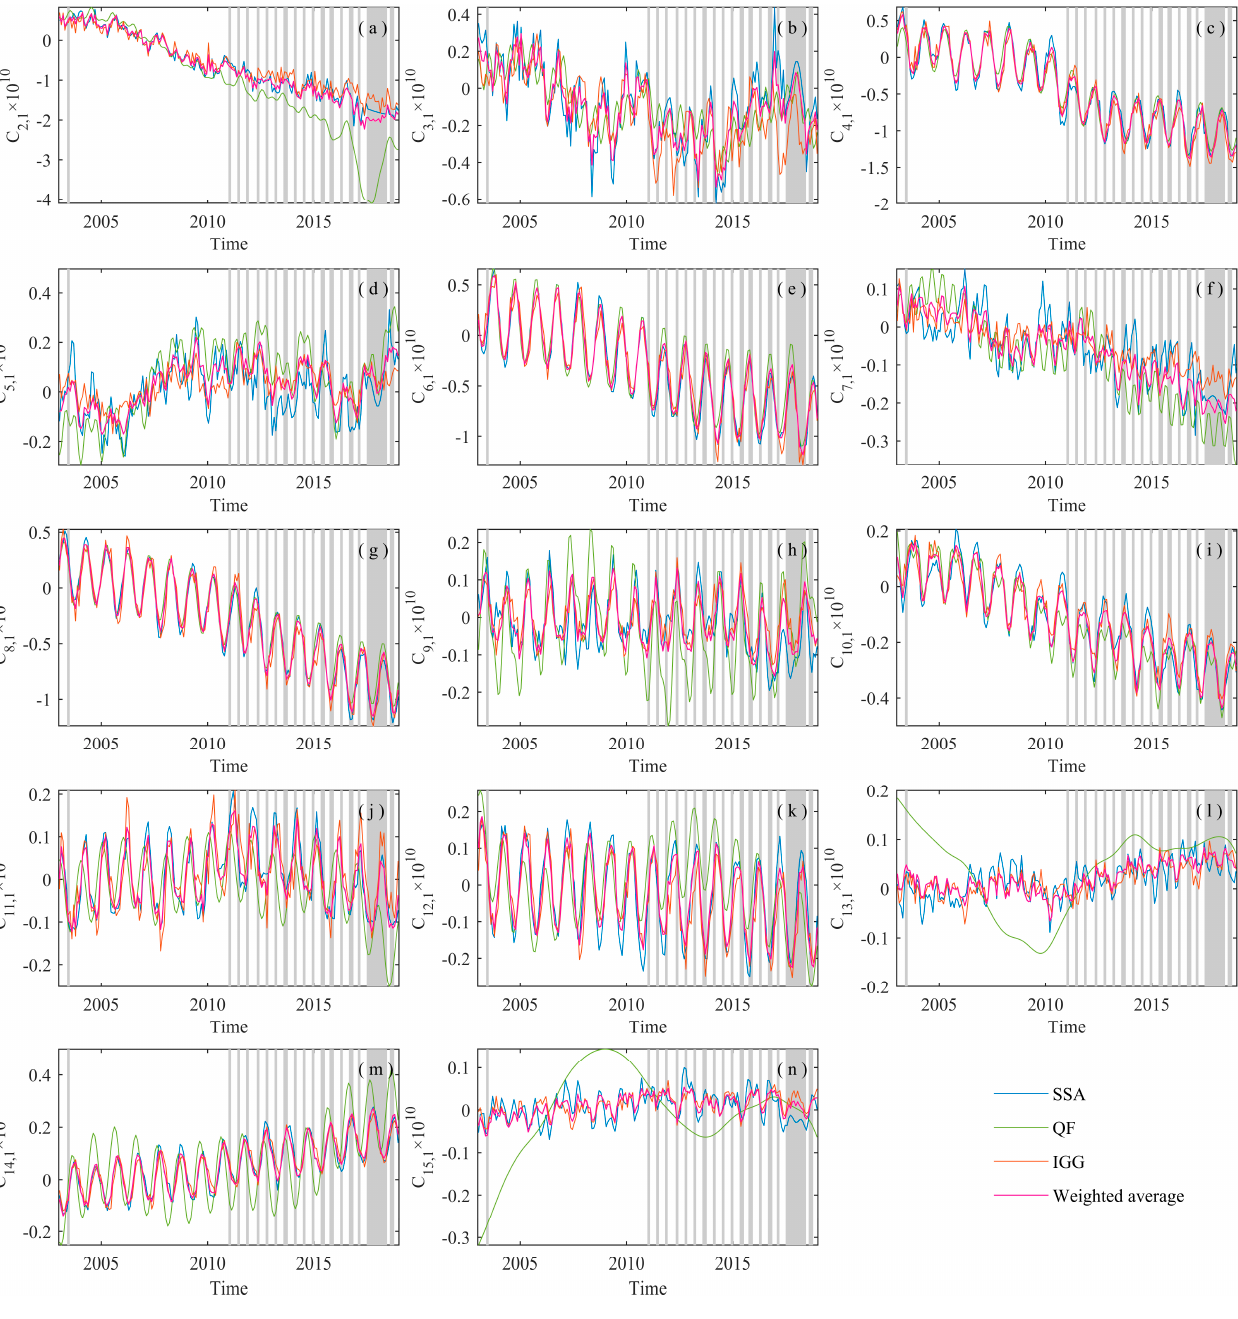
Figure 12. Time series of selected coefficients of the SSA, QF, IGG, and the fused results. The gray bars indicate the location of the missing data of GRACE. ( a )–( n ) denote the C 2,1 to C 15,1 time series, respectively.